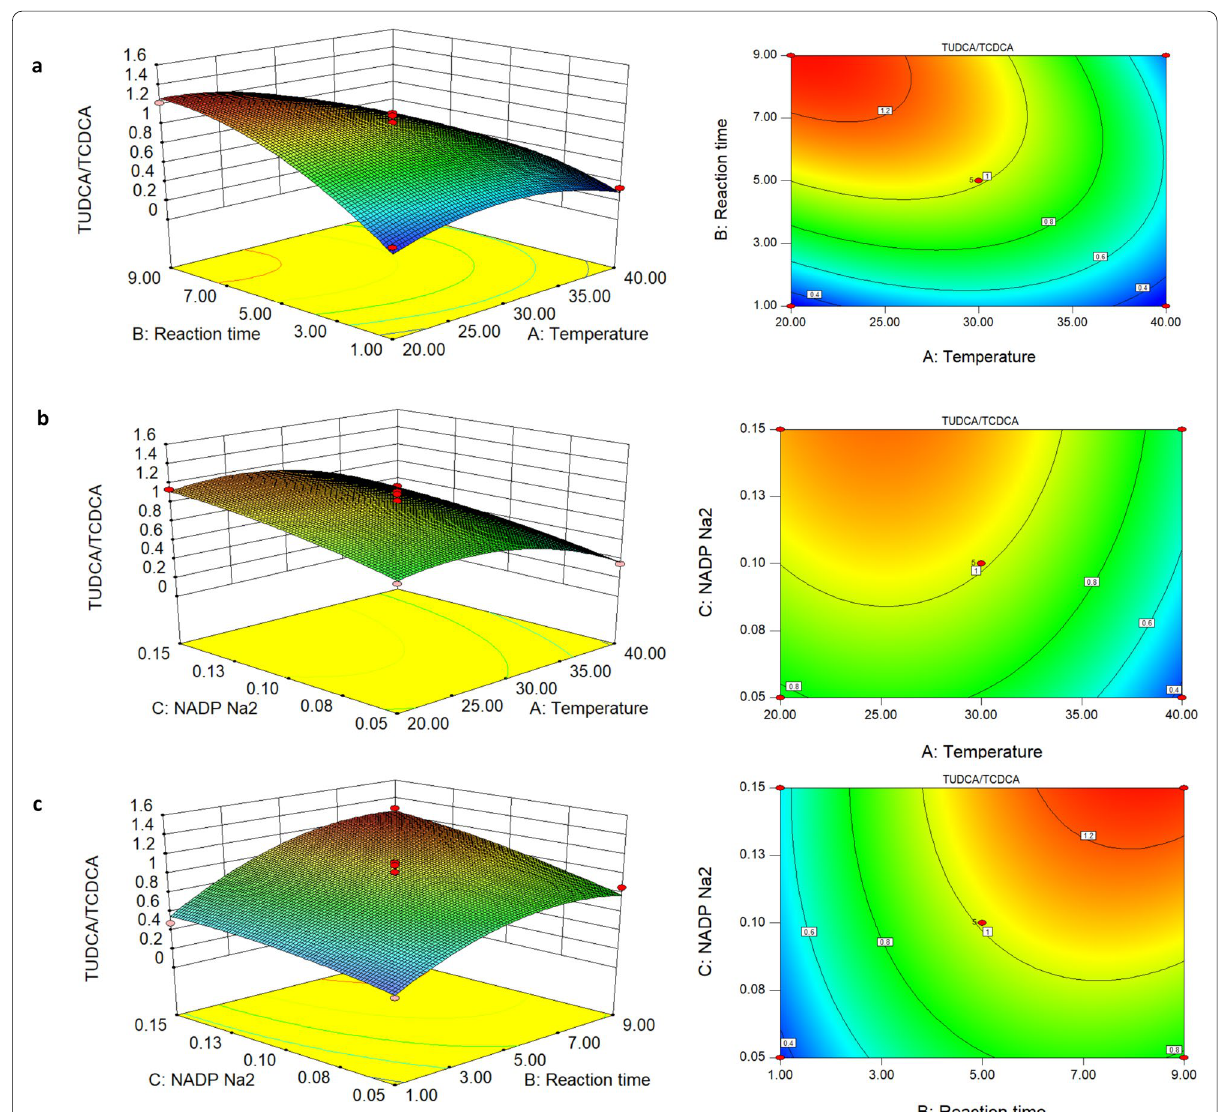
Fig. 4 Results of response surface methodology for